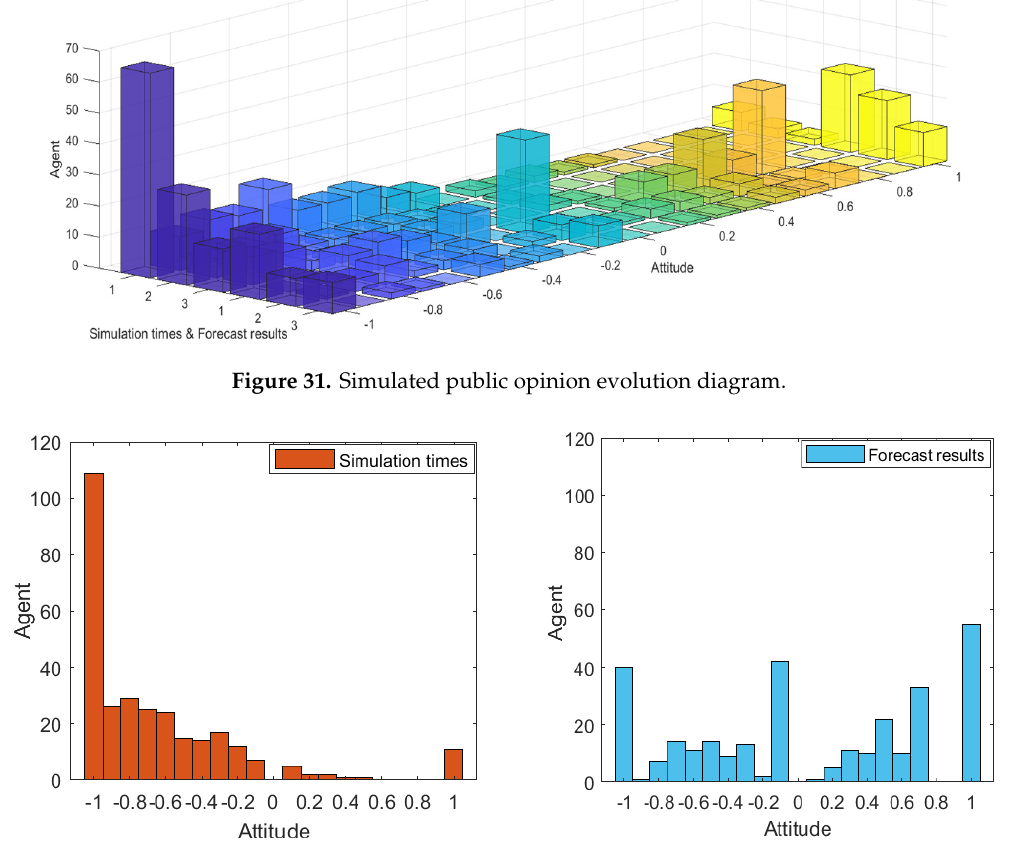
Figure 33. Simulated public opinion evolution diagram based on the literature [14].